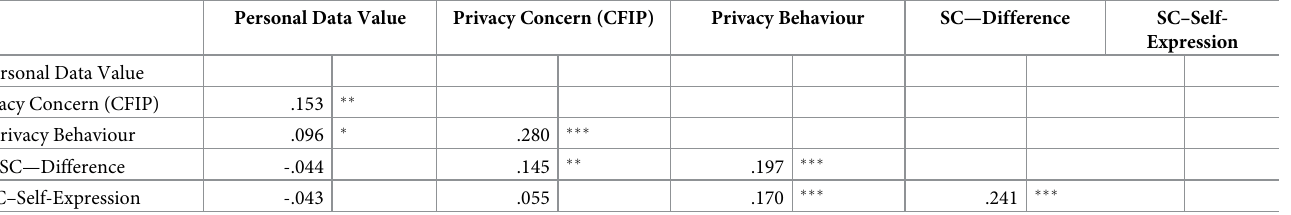
Table 5. Correlation coefficients for research variables in Study 2.